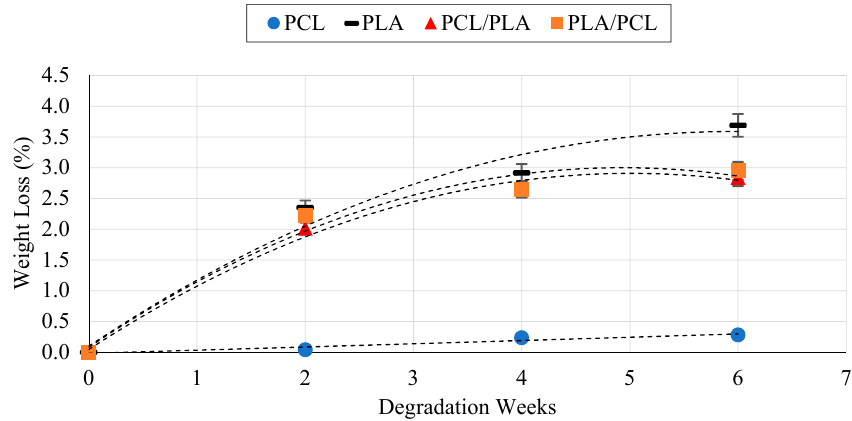
Figure 7. Degradation rate results for PCL, PLA, PCL/PLA, and PLA/PCL stents.